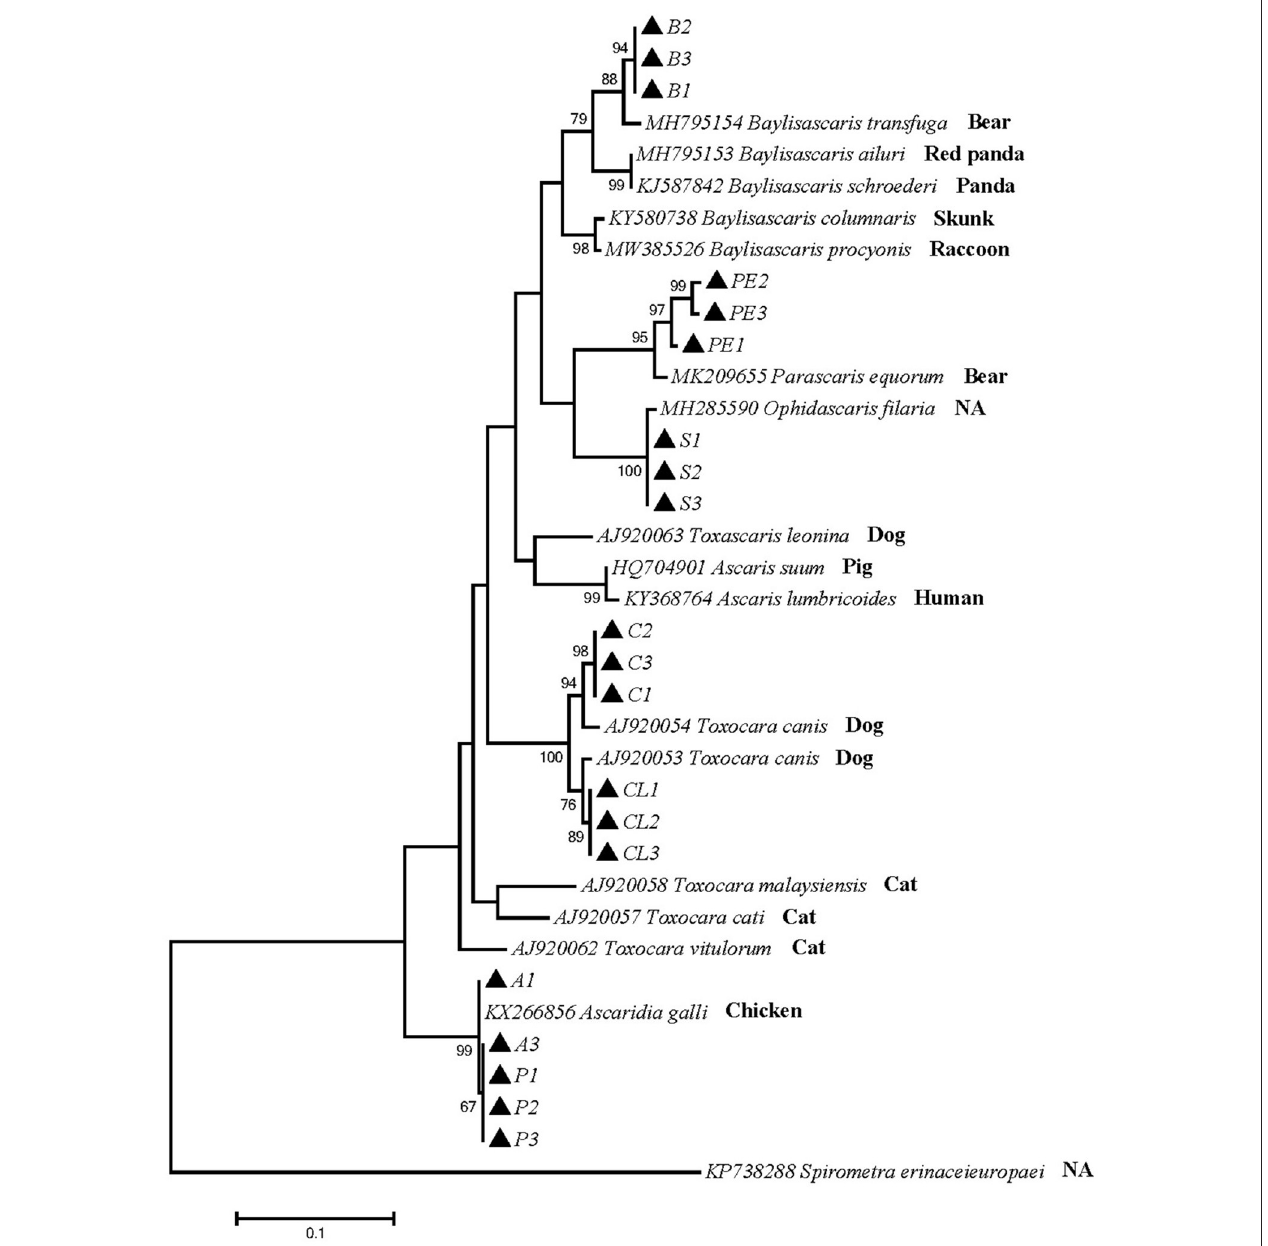
FIGURE 3 | Neighbor-Joining estimates of the phylogenetic relationships of ascarids based on p cox 1 gene computed in MEGA version 7.0 under the Kimura 2-parameter model; The confidence levels in each node were assessed with the bootstrap method (1,000 pseudoreplicates) and bootstrap values > 50; The genotypes identified in this study are indicated by filled